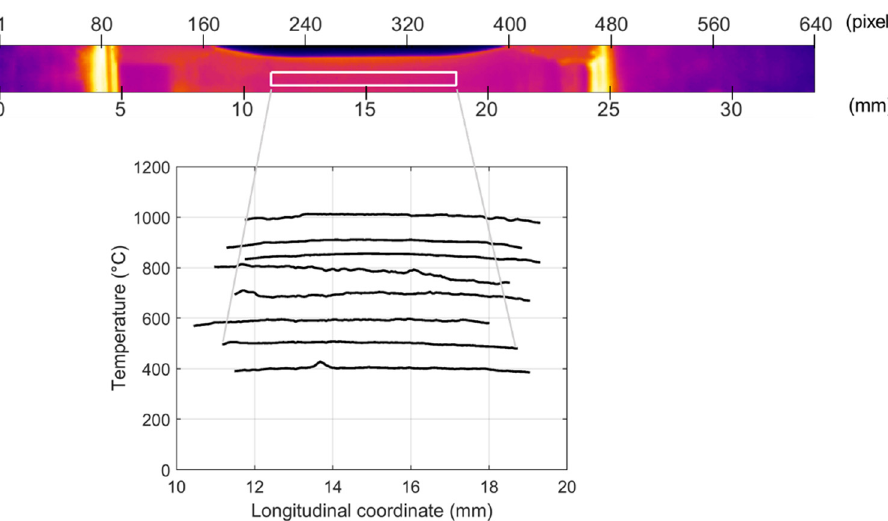
Figure 5. Check of the uniformity of heating: for each testing condition varying the initial tempera- ture, the map of the temperature obtained by the infrared camera was used to evaluate the average temperature measured at several longitudinal coordinates along the gauge length of the specimen.